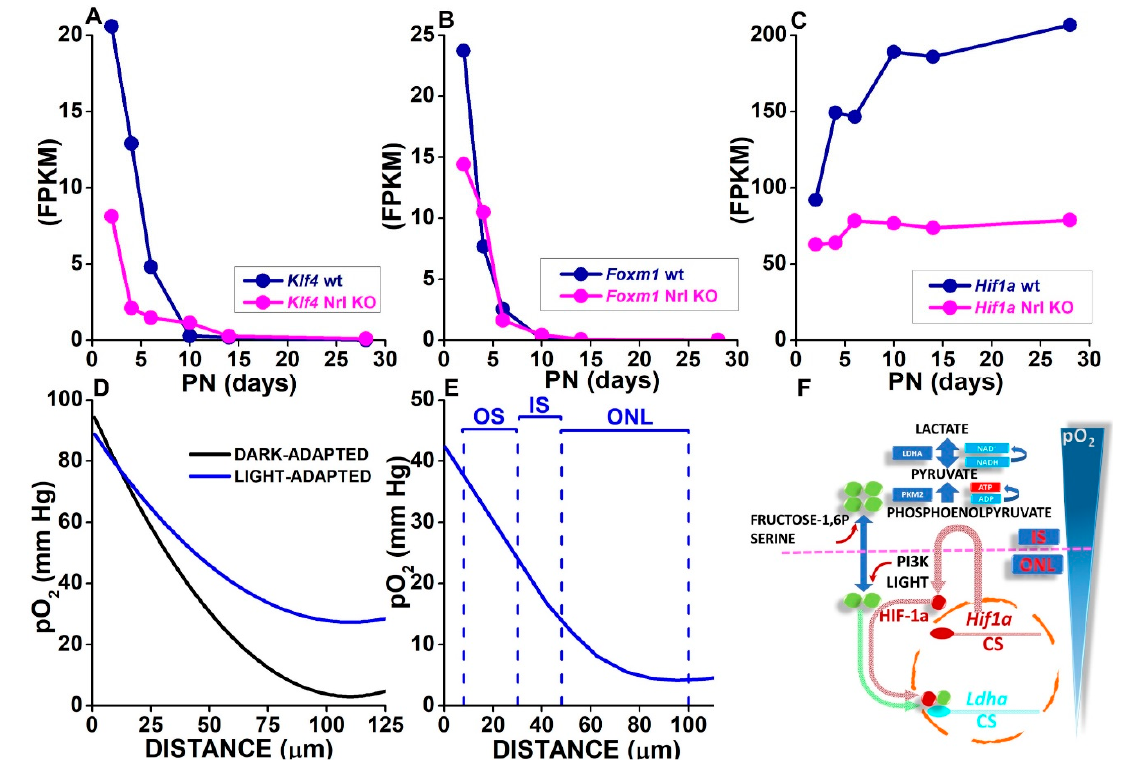
Figure 4. ( A – C ) Datapoints plot expression data (FPKM) for Klf4 ( A ), Foxm1 ( B ), and Hif1a ( C ) genes replotted from the RetSeq Database of transcriptome analysis of flow-sorted mouse rod precursors at different developmental ages, from postnatal (PN) days 2, 4, 6, 10, 14, and 28. Blue and magenta circles plot data for rods isolated from wt and Nrl -KO mice, respectively. ( D ) Curves are drawn according to a diffusion-based model using average values from best-fitting curves for pO 2 changes measured by oxygen-sensing microelectrodes from ChC to ONL in dark-adapted (black) and light-adapted (blue) cat retina (see text). ( E ) The blue curve plots average values from best-fits of pO 2 values in light-adapted mouse retinas. The upward dashed lines were drawn at positions corresponding to the OS tips, the OS/IS junction, the OLM, and the OPL (left to right), from the CT optoretinogram (see text). ( F ) Scheme of synergic activation of Ldha transcription by dimeric/monomeric PKM2 and HIF-1a. The downward blue triangle represents the pO 2 gradient across the SRS, with lower levels at the ONL than at the IS. Hif1a transcription translates into HIF-1a transcription at the IS and may escape degradation by reduced pO 2 levels, then shuttling back to the cell nucleus to establish a complex with dimeric/monomeric PKM2 and bind the Ldha promoter to increase its